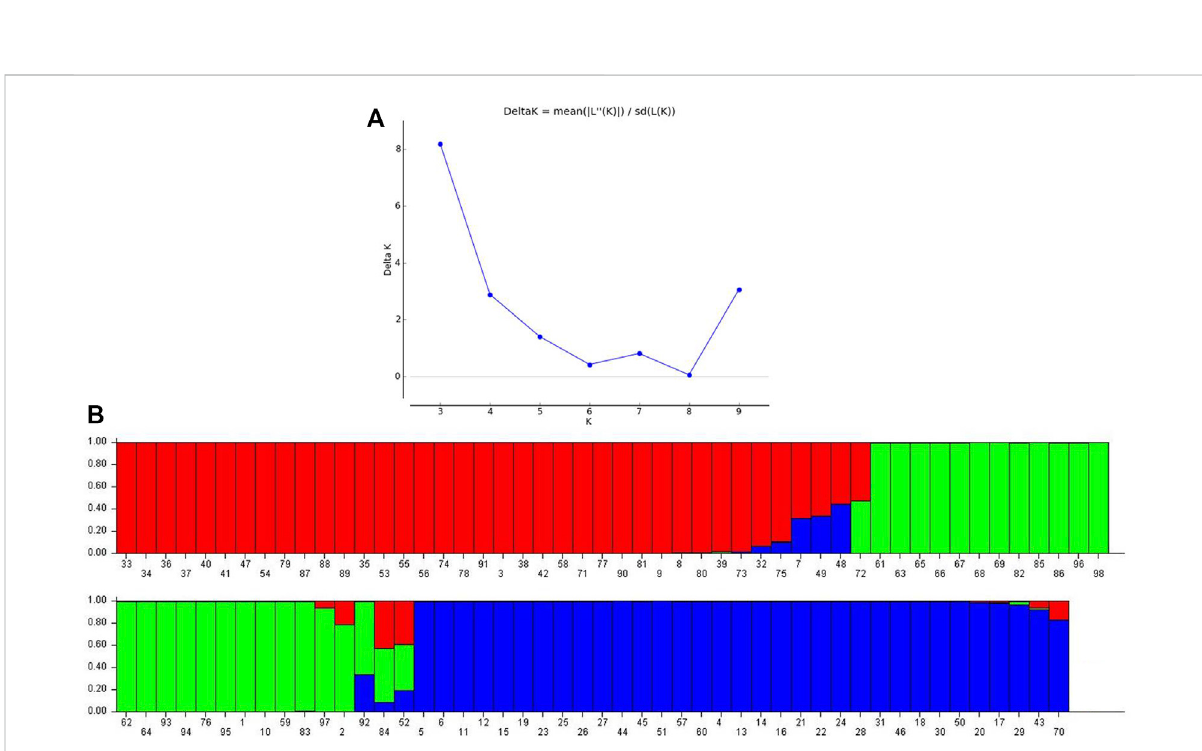
FIGURE 3 Population genetic structure analysis: (A) Evanno Delta K-based sub-population prediction. (B) Three distinct sub-populations in a chosen Vigna